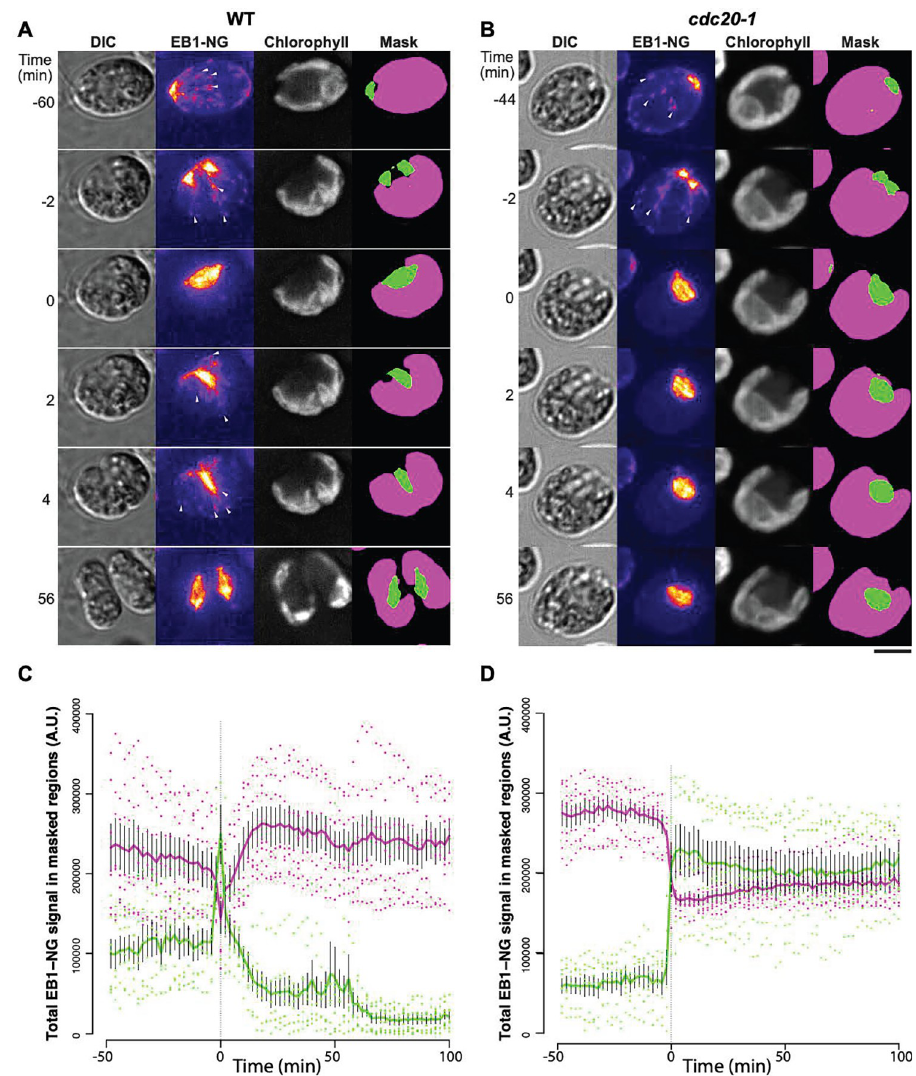
Fig 11. Suppression of cytoplasmic EB1-NG comets during mitosis. (A, B) Representative examples of wild-type (A) and cdc20-1 (B) cells expressing EB1-NG. Time-lapse microscopy was done using Method 3 (see Materials and Methods). Bar, 5 μ m. (C, D) Regions representing polar dot, spindle, and furrow (green in A, B) and cytoplasm (magenta in A, B) were masked as described in Materials and Methods. Total signals in the masked regions are presented as mean ± SEM (N = 7), with values from individual cells overlaid as dots. Time zero (first appearance of complete spindle) was determined empirically for each cell. See S7 Fig for individual